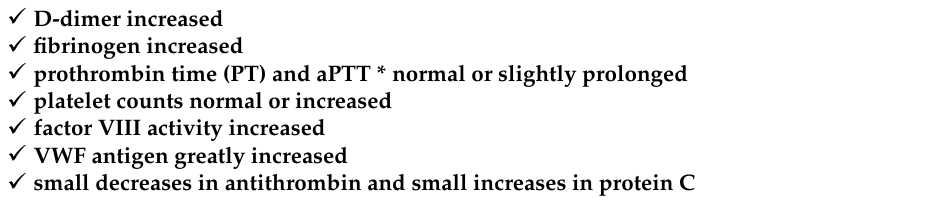
Table 2. The hypercoagulable state and predominant coagulation abnormalities in patients with covid-19 [Panigada M, Bottino N, Tagliabue P, et al. Hypercoagulability of COVID-19 patients in Intensive Care Unit. A Report of Thromboelastography Findings and other Parameters of Hemo- stasis. J Thromb Haemost 2020]. Table 3. The International Society on Thrombosis and Haemostasis (ISTH) scoring system. A ISTH score of 5 or more points suggests DIC is probable.